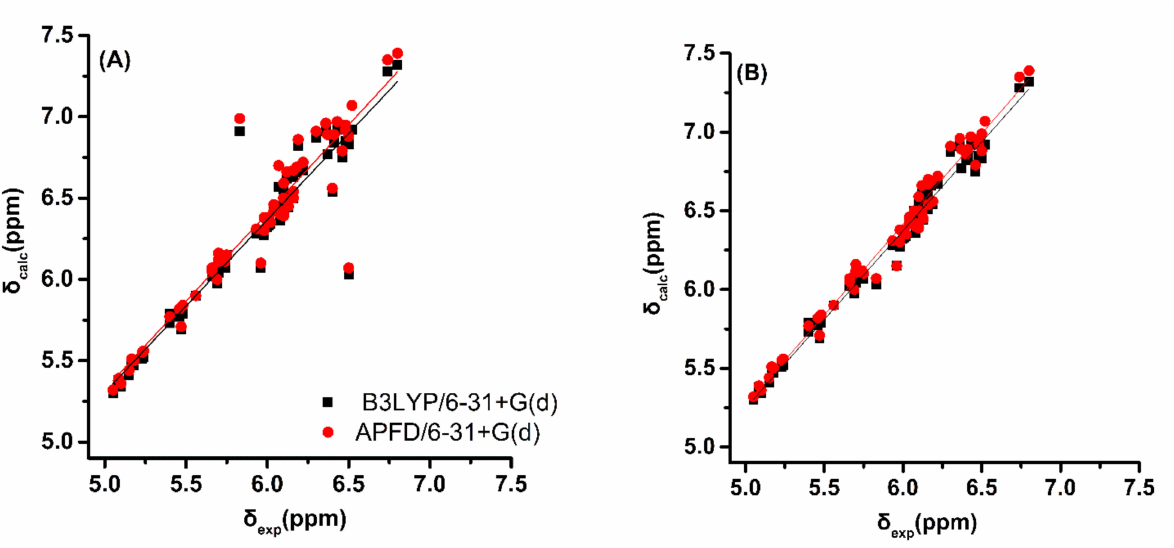
Figure 9. ( A ) Calculated, δ calc , 1 H NMR chemical shifts of the olefinic protons at the GIAO/B3LYP/6–311+G(2d,p) level with CPCM) vs. experimental, δ exp , chemical shifts with energy minimization using B3LYP/6–31+G(d) and APFD/6–31+G(d) for (Z )-1,3,5-hexatriene, ( E )-1,3,5-hexatriene, ( E,Z,E )-2,4,6-octatriene, ( E,E,E )-2,4,6-octatriene, α -oleostearic acid (9 Z , 11 E , 13 E ), β -oleostearic acid (9 E , 11 E , 13 E ), punicic acid (9 Z , 11 E , 13 Z ), and (10 E , 12 E , 14 Z )-, (10 E ,12 Z ,14 Z )-, (10 Z , 12 Z , 14 E )-, and (10 Z , 12 E , 14 E )-hexatrienyl acetates. ( B ) The same as in ( A ); however, the literature experimental chemical shift data ( δ exp ) of the compounds shown in Figure S14 have been